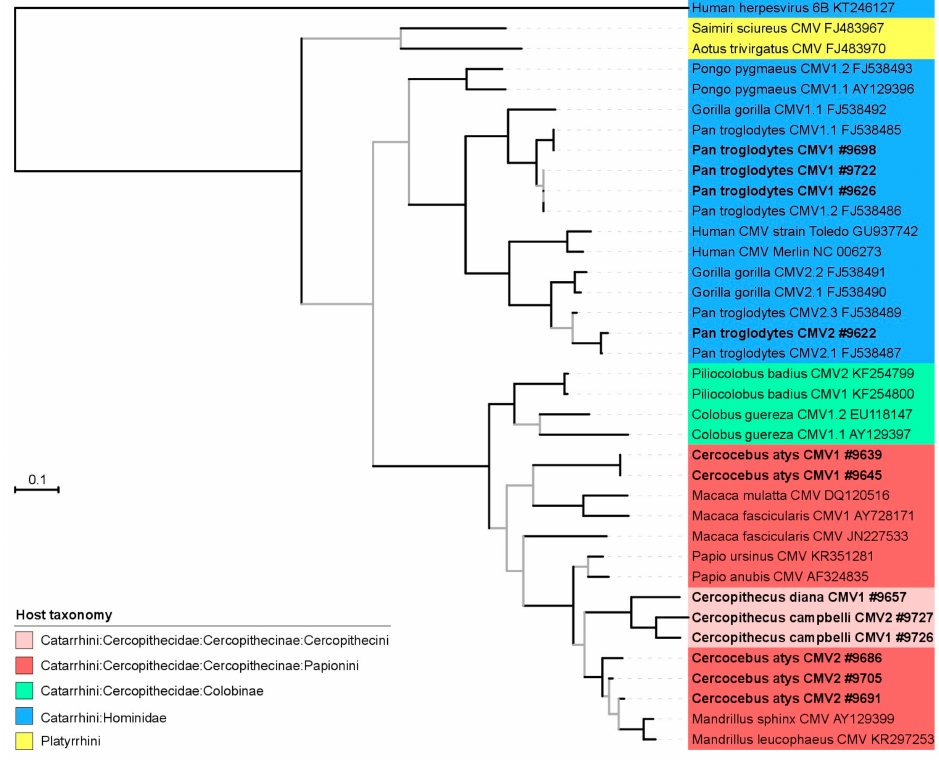
Figure 3. Maximum likelihood tree of partial CMV UL55 amino acid sequences. Sequences generated for this study are bold and displayed with their sample number (accession numbers in Table 1). Internal branches supported by Shimodaira-Hasegawa-like approximate likelihood ratio test (SH-like aLRT) values <0.95 are grey. The common names of the hosts after which the viruses are named are given in the legend of Figure